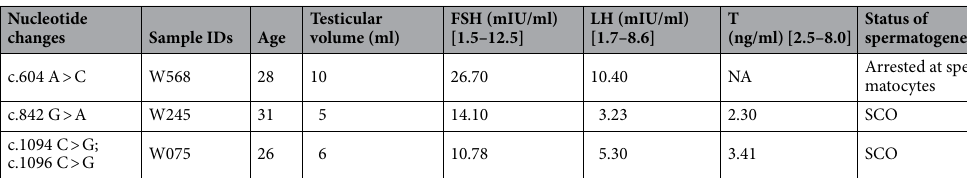
Table 2. Clinical information of NOA patients with missense mutations in ESX1 . FSH , follicle stimulating hormone; LH , luteinizing hormone; T , testosterone; SCO , Sertoli cell only NA : not available.